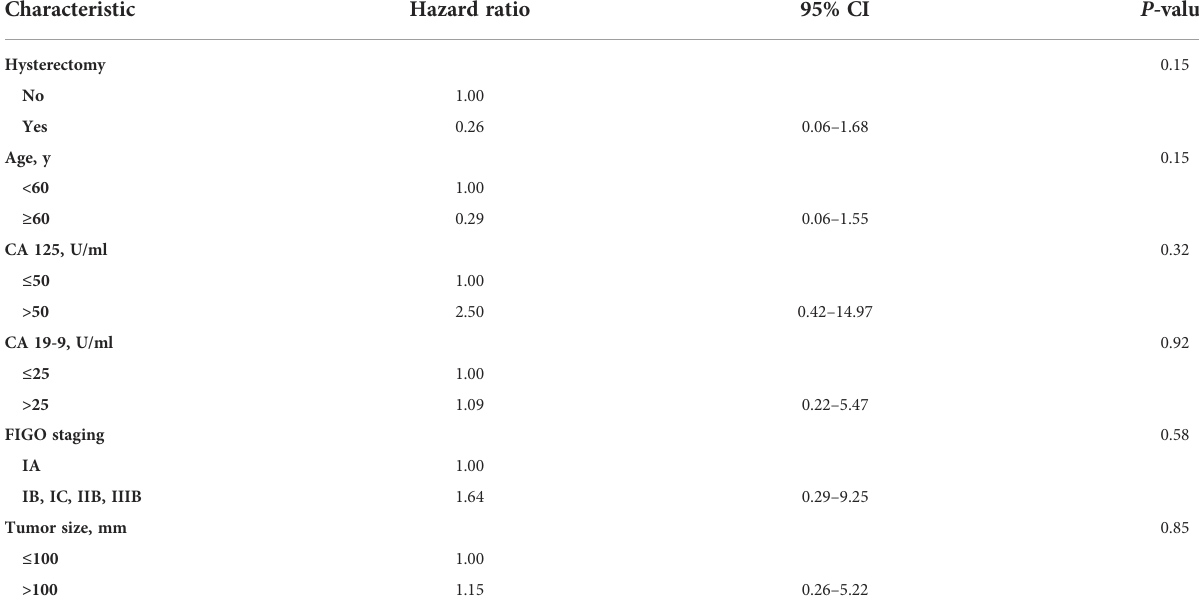
TABLE 3 Results of Cox proportional hazards model for disease-free